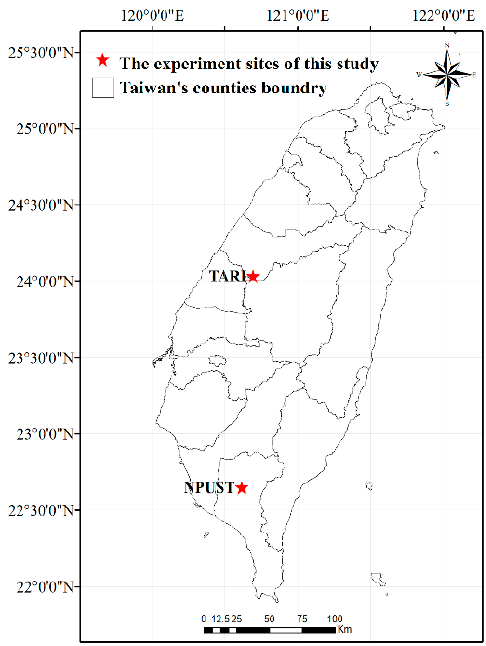
Figure 1. Experimental sites of this study.